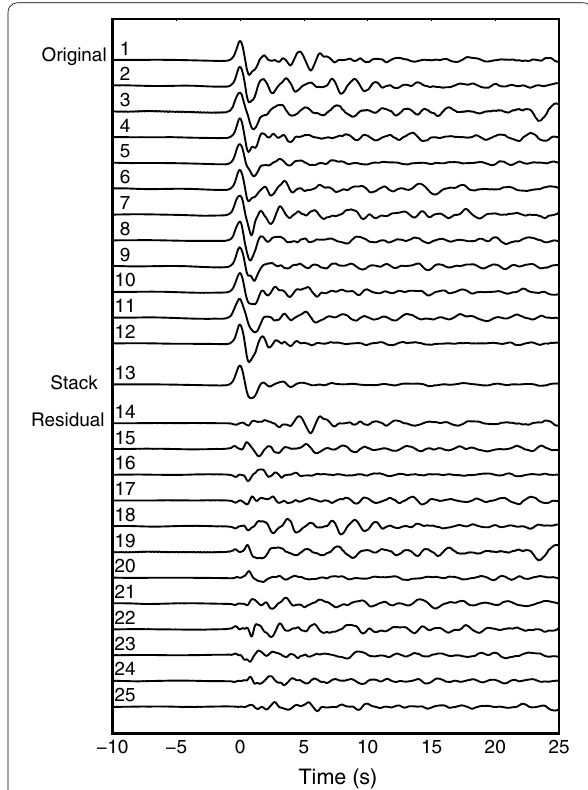
Fig. 3 Original velocity waveforms (complete wavefield) and residual waveforms (fluctuating wavefield) of Event 2010.02.15.21.51 (Lat: 7.22, Lon: 128.72, Depth: 126.0 km). The single traces are − time-shifted according to the first peak of direct P-wave and normalized to the individual maximum amplitudes. The stack in the middle represents the summed waveform from seismograms recorded by 12 stations in the